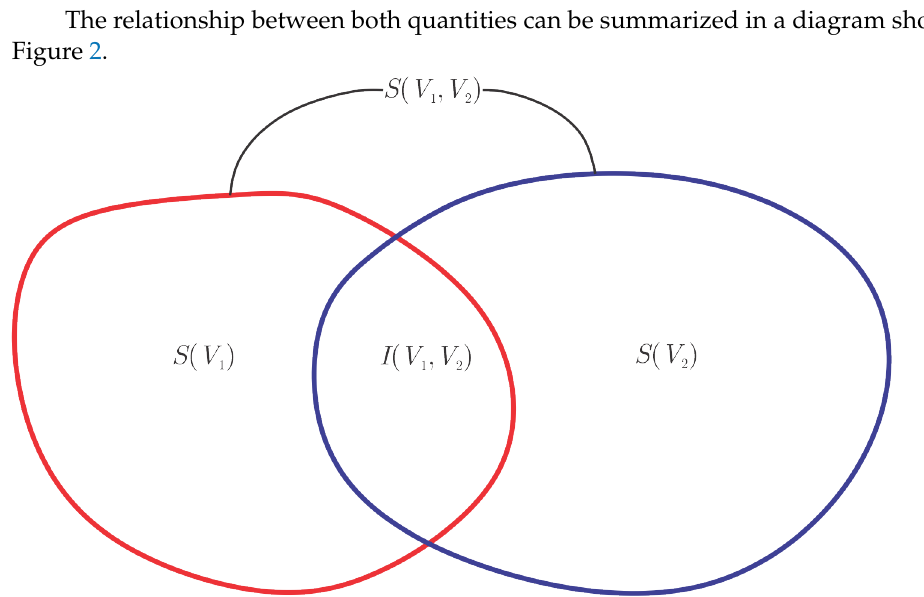
Figure 2. The relationship between entropy and mutual